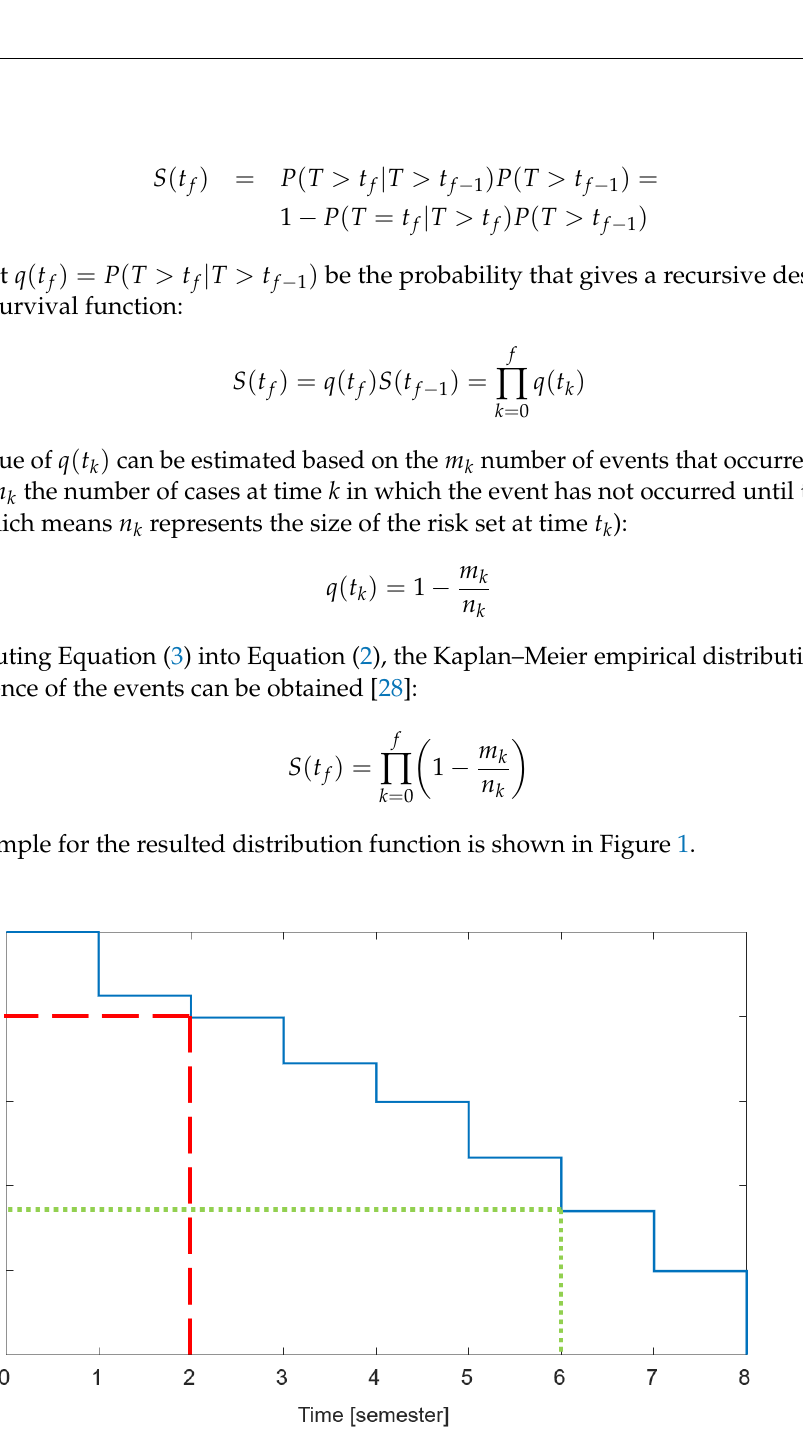
Figure 1. Example of the Kaplan–Meier empirical survival function. In this example, the probability that the event (e.g., the dropout) will occur after the second time instance (e.g., semester) is 0.8, while the probability that the event will occur later than the sixth time instance is